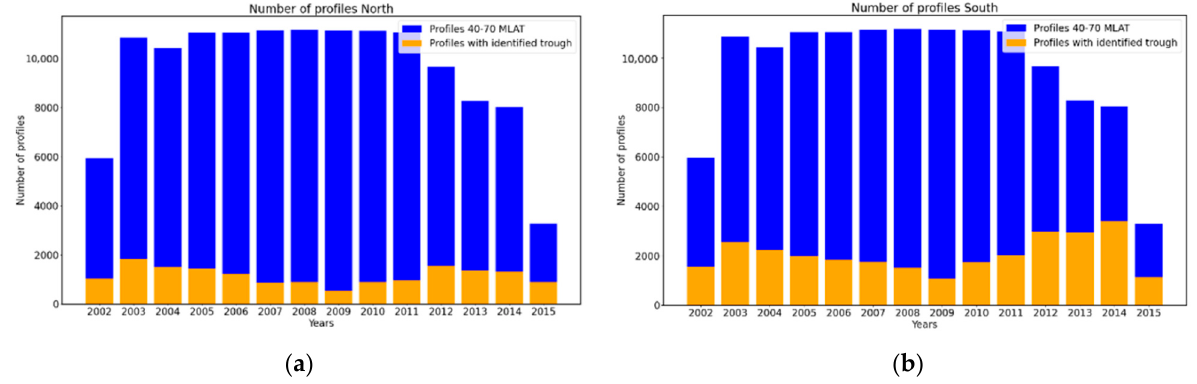
Figure 3. Number of total and detected MIT profiles for each year in the northern hemisphere ( a ) and the southern hemisphere ( b